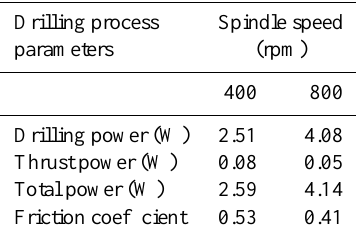
Table 1. Bone model drilling process parameters for simulation